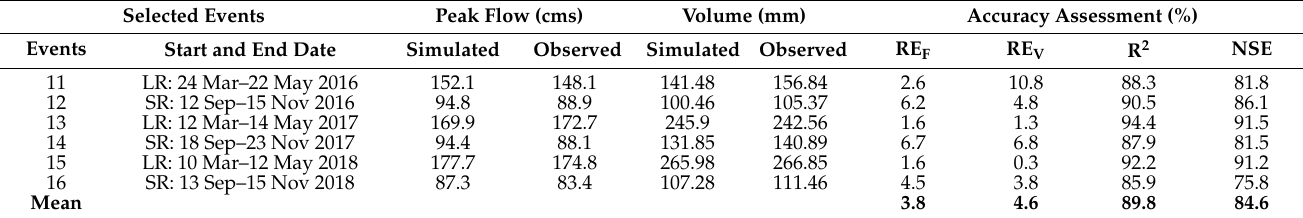
Table 6. Observed and simulated peak flow and volume for validation